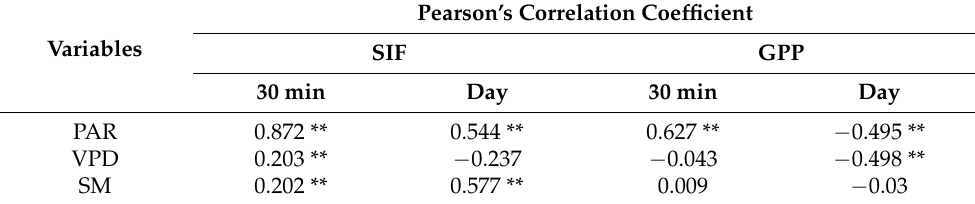
Table 1. Correlations between canopy SIF and GPP with meteorological factors like PAR, VPD, and SM based on 30 min and daily data observed in oak canopy. The whole analyses were based on data on sunny days. ** for p < 0.01.